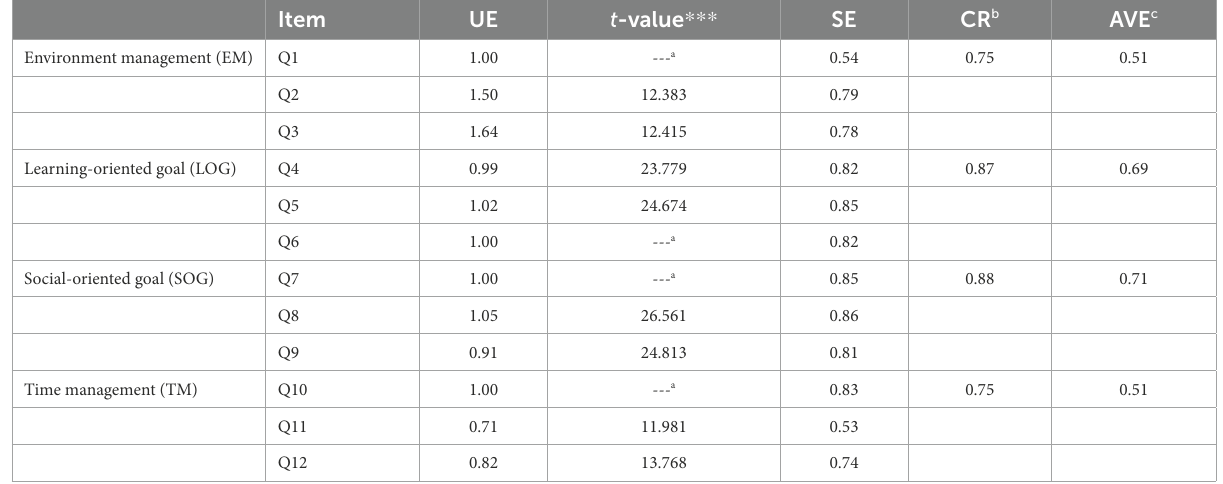
TABLE 1 Results of confirmatory factor analysis.